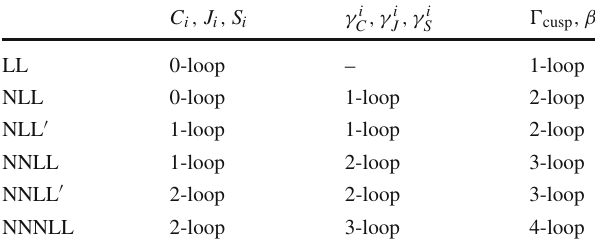
Table 1 Perturbative ingredients at different orders in resummed per- turbation theory C i , J i , S